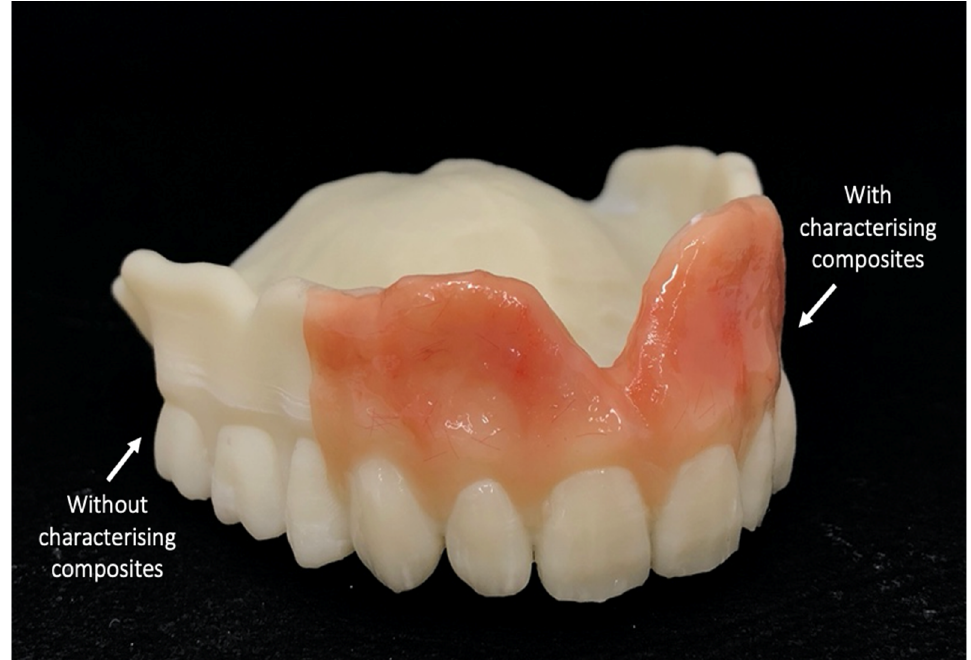
Figure 1. An example of tooth-coloured PMMA denture with characterising composites; note only the anterior portion is characterised, as an example.